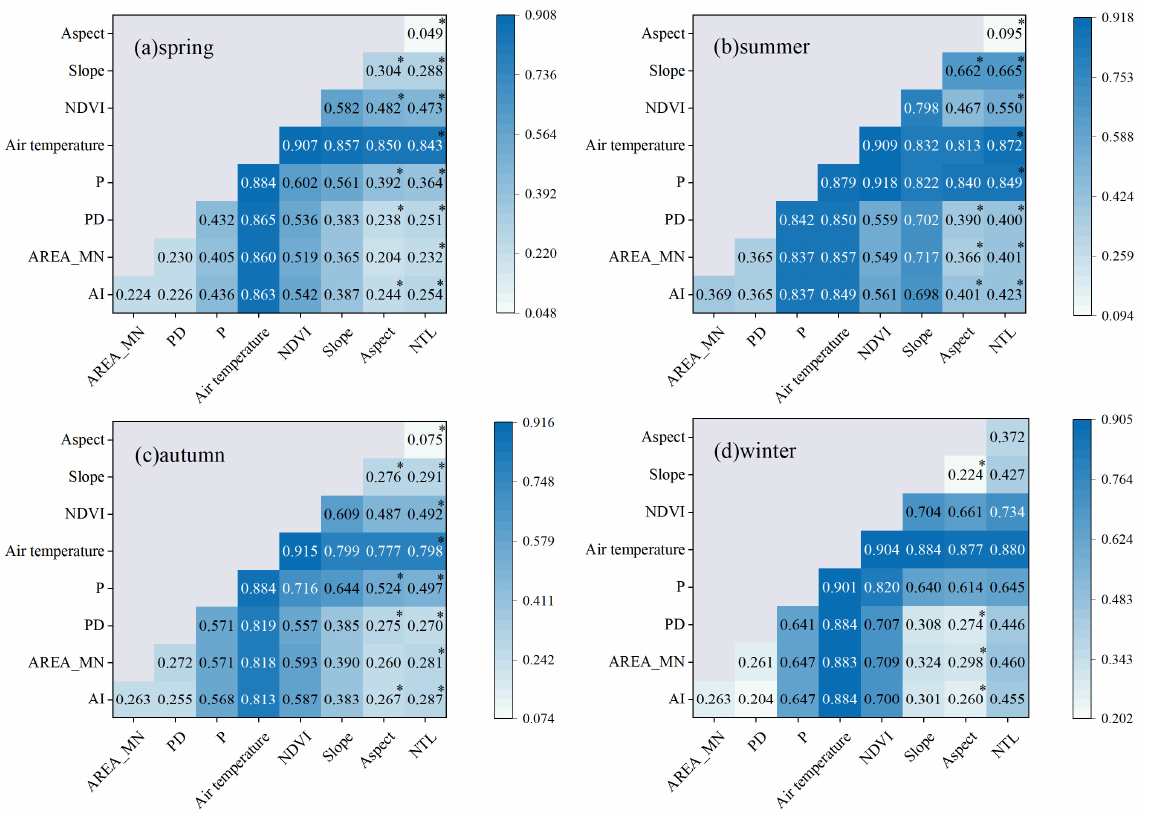
Figure 7. Interaction detection diagram in 2020 (* represents nonlinear–enhance; unmarked values indicate bi-variable enhance).